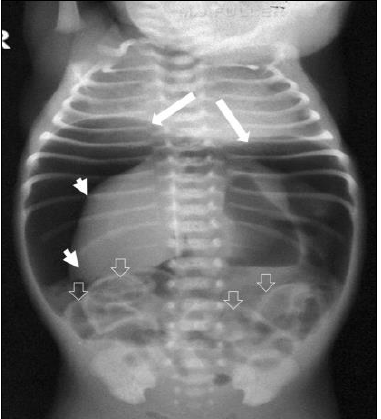
Figure 5: Pneumoperitoneum. Big white arrows showed air under diaphragm leading to its elevation. Small white arrows delineate pushed down liver border. Empty arrows show Rigler’s sign.